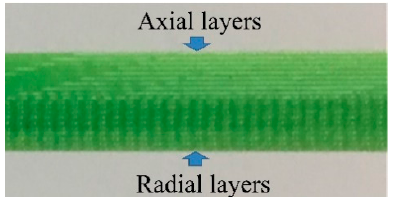
Figure 19. Local diagram of the experimental sample.